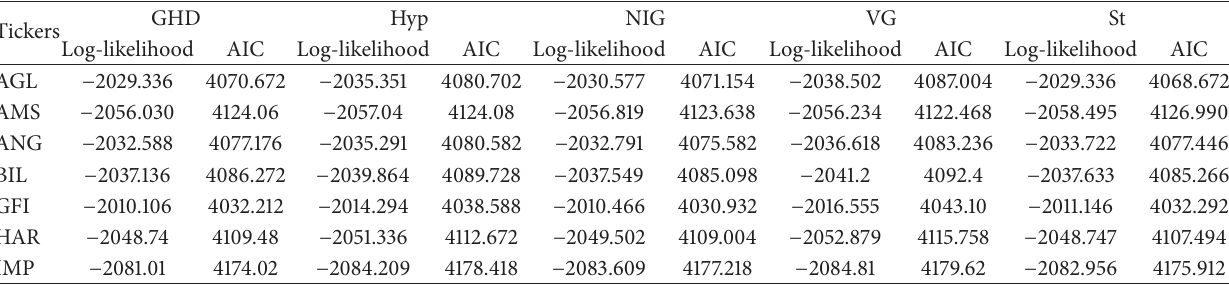
Table 3: Log-likelihood and